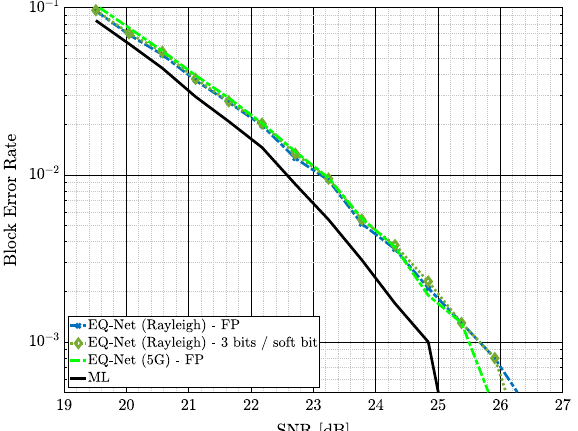
Fig. 11 Quantization performance of EQ-Net under a severe distributional shift induced by training on i.i.d. Rayleigh fading channels and testing on the 5G-NR CDL-A MIMO channel model for 2 × 2 , 64-QAM, and LDPC-coded with size (324,